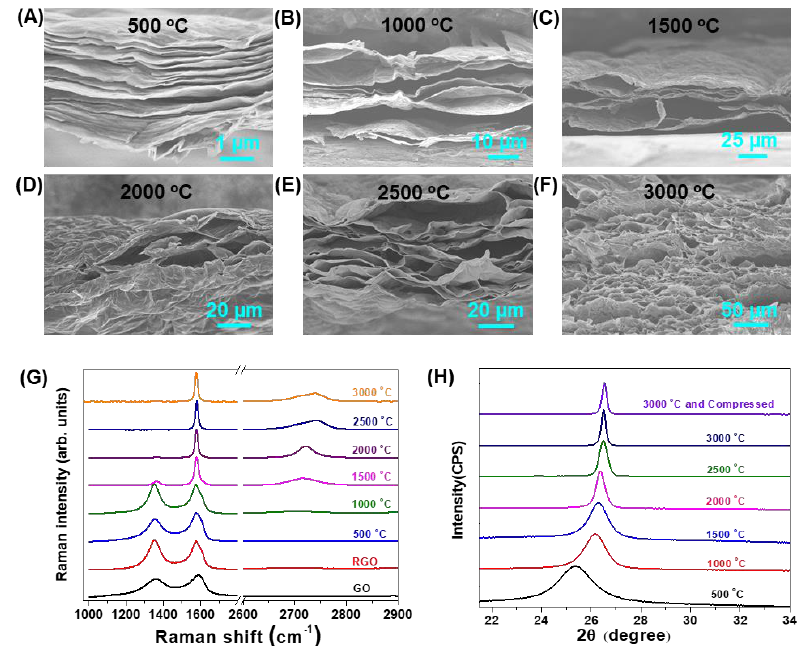
Figure 1. ( A – F ) SEM images of the cross-sections of graphene films after different annealing tem- peratures. ( G ) Raman spectra and ( H ) XRD patterns of GO films, HI-reduced GO films, and graphene films treated under different annealing temperatures.